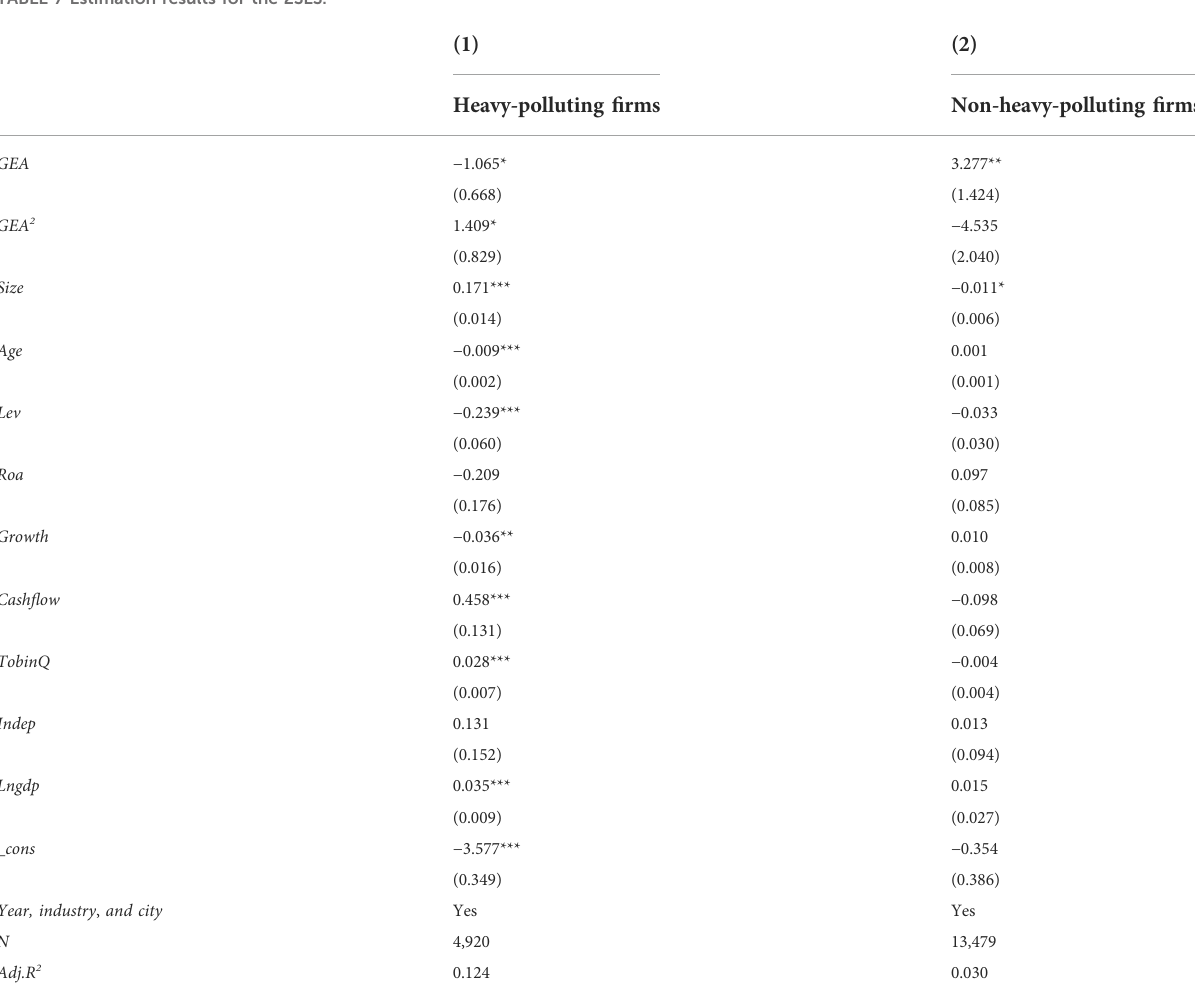
TABLE 7 Estimation results for the